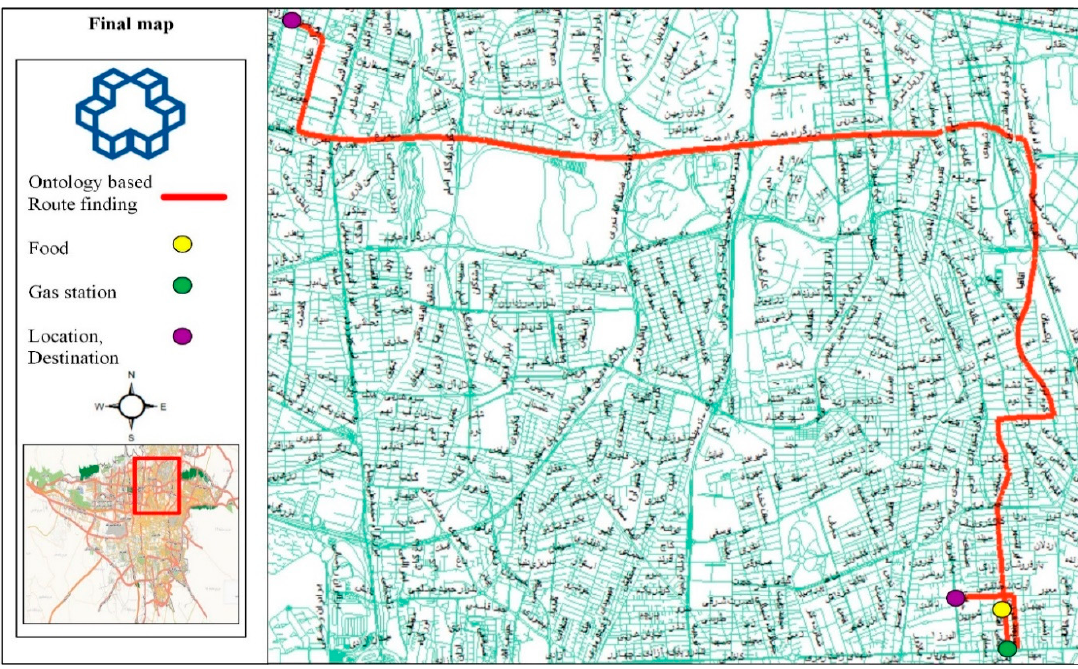
Figure 16. The proposed route with two stops on the way.